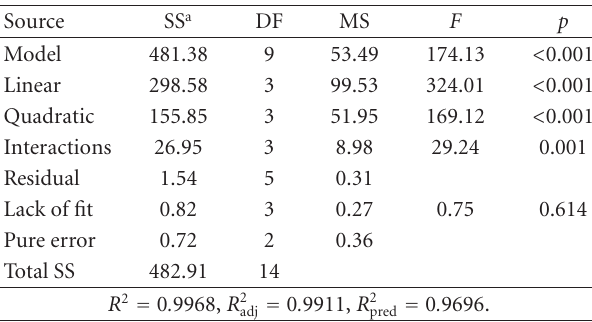
Table 4: Analysis of variance (ANOVA) for regression